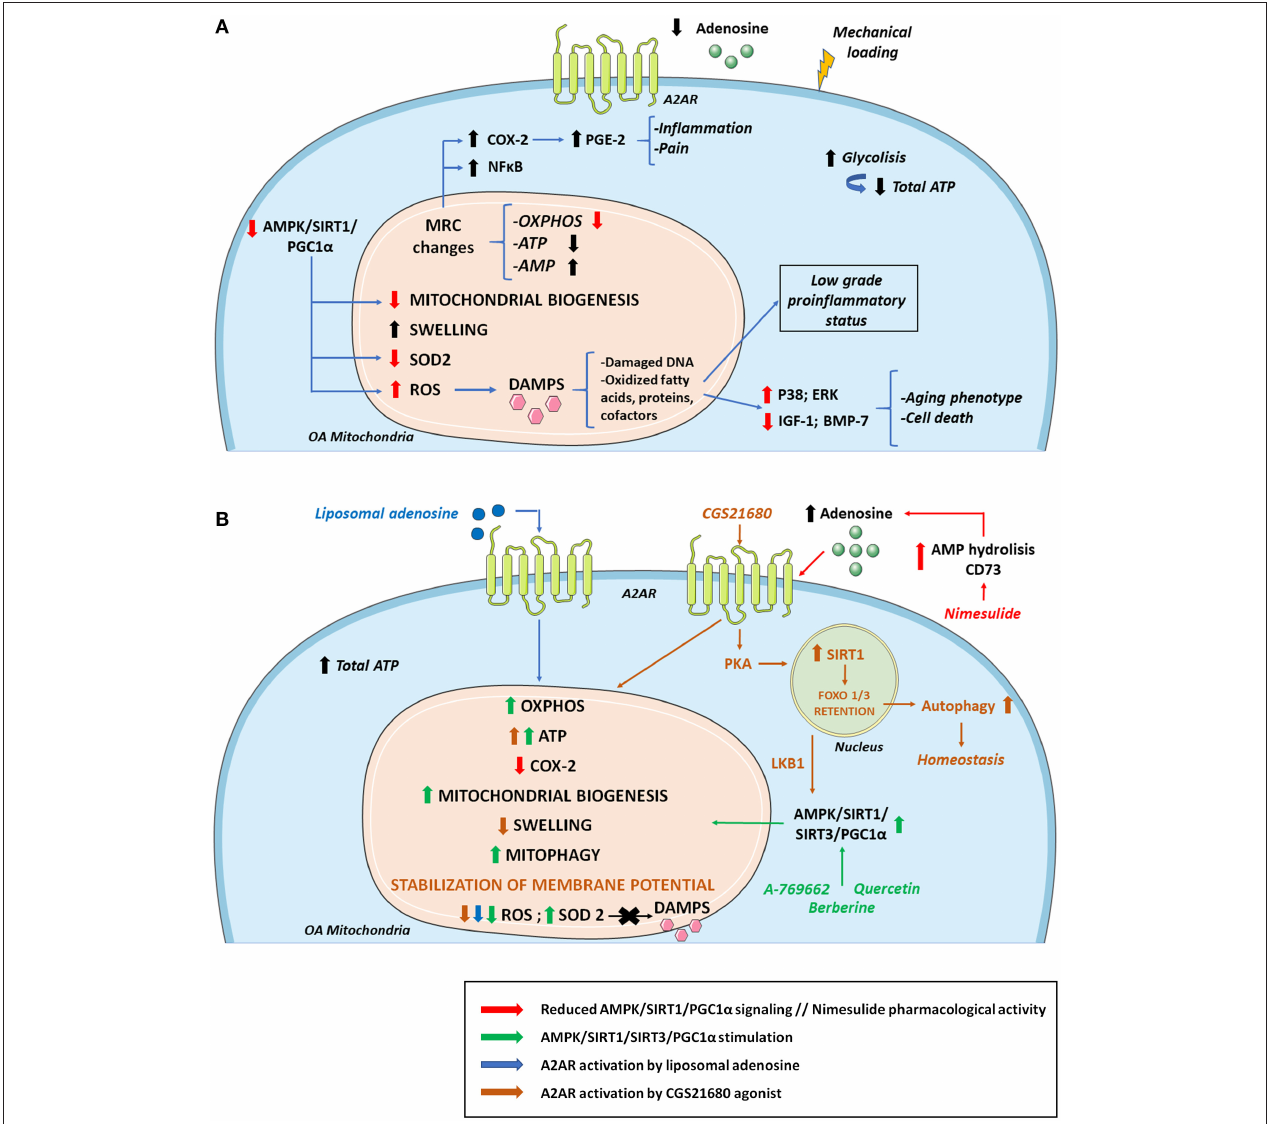
FIGURE 3 | Osteoarthritis (OA) mitochondrial metabolism and its modulation by A2AR and AMPK stimulation. (A) During the development of OA, cellular metabolic alterations occur. There is an increase in glycolysis activity to compensate the energy requirement necessary to repair damaged cartilage. However, total ATP levels decrease due to mitochondrial defects together with sustained mechanical loading. Changes in the MRC and its complexes impair ATP and AMP production. As a result, there are lower extracellular levels of ATP and adenosine which diminish A2AR signaling. These alterations in the MRC cause an increase in proinflammatory molecules and transcription factors such as COX-2 and NF- κ B, respectively, aggravating inflammation and pain. Reduced AMPK/SIRT1/PGC-1 α signaling compromises mitochondrial biogenesis and OXPHOS. There is also a decrease in antioxidant enzymes such as SOD2 that cause increases in ROS production, contributing to the release of DAMPS that aggravate the inflammatory status, stimulating catabolic pathways (p38; ERK) and reducing anabolic pathways (IGF-1; BMP-7), which supposes cell death and an aging phenotype. (B) Mitochondrial OA impairment can be partly reversed by AMPK and A2AR stimulation. Quercetin, berberine and pharmacological AMPK activator A-769662 can activate AMPK/SIRT1/PGC-1 α and AMPK/SIRT3 pathways increasing OXPHOS, ATP, mitochondrial biogenesis, mitophagy, and SOD2 activity. AMPK stimulation also promotes a decrease in ROS production with reduced DAMPs secretion diminishing inflammation and aging phenotype. Regarding ROS level reduction, similar effects are found when A2AR is activated by agonists like liposomal adenosine. Moreover, A2AR agonist CGS21680 stimulates SIRT1 via PKA allowing FOXO1/3 retention and increased autophagy. CGS2168 indirectly activates AMPK through LKB1. Nimesulide increases extracellular adenosine levels favoring a reduction in the expression of COX-2 and the associated inflammation and pain. AMP, adenosine monophosphate; AMPK, AMP activated protein kinase; BMP-7, bone morphogenetic protein 7; DAMPS, damage associated molecular patterns; IGF-1, insulin growth factor 1; LKB1, liver kinase B1; MRC, mitochondrial respiratory chain; OXPHOS, oxidative phosphorylation; PGC-1 α , peroxisome proliferator-activated receptor- γ coactivator-1 α ; PKA, protein kinase A; SIRT1, sirtuin 1; SIRT3, sirtuin 3; SOD2, superoxide dismutase.